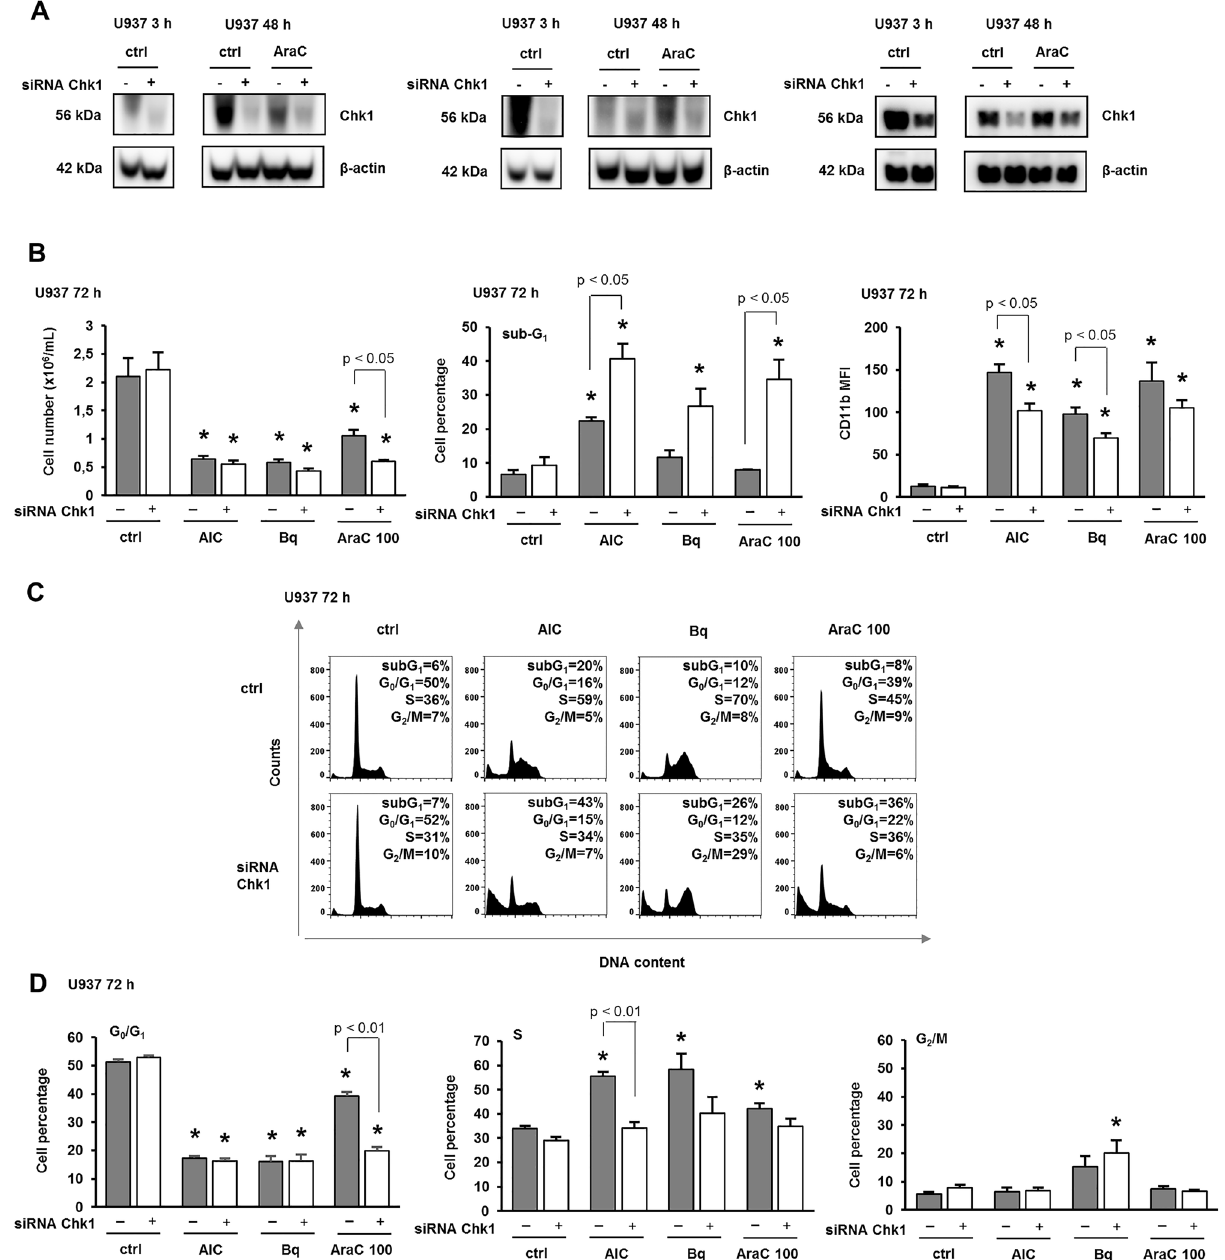
Figure 4. Down-regulation of Chk1 reduces the effects of cytarabine on the expression of differentiation markers and S-phase arrest. U937 cells were transfected with siRNA against CHK1, and respective nontargeting siRNA was used as a negative control. AICAr (AIC) (0.2 mM), brequinar (Bq) (0.5 µM) and AraC (100 nM) were added 24 h after transfection. ( A ) Total cell lysates were isolated 3 or 48 h after the addition of agents and analyzed by Western blotting for the level of Chk1. Western blot analyses are shown for each of the three independent experiments. ( B ) The number of viable cells, the expression of differentiation markers and the cell cycle progression were analyzed by flow cytometry 72 h after addition of agents. ( C ) Representative histograms of propidium-labeled cells analyzed by flow cytometry. ( D ) Percentage of cells in G 0 /G 1 , S, and G 2 /M-phases of the cell cycle. Results are mean ± S.E. (error bars) of at least three independent experiments. *, p < 0.05 (Student’s t-test) compared with control